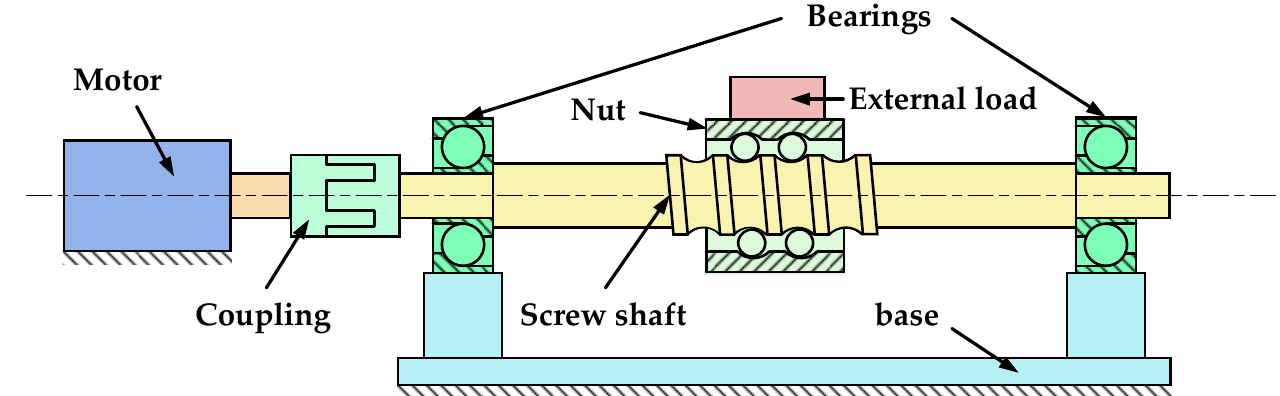
Figure 2. Simplified model of the EMA test stand.